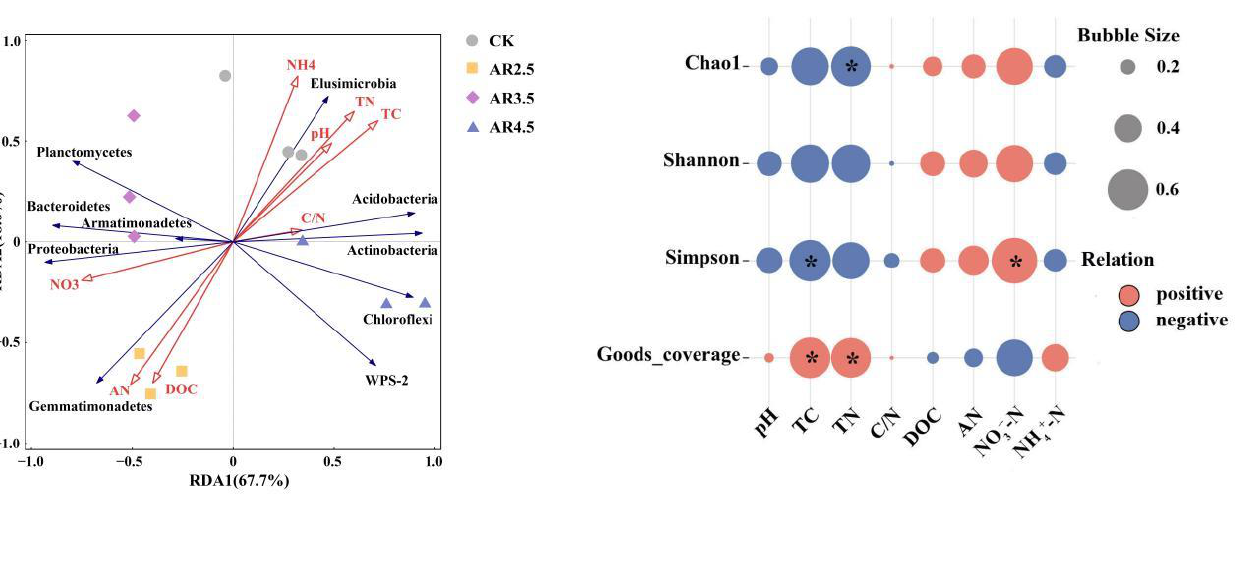
Figure 4. ( a ) Redundancy Analysis (RDA) of the effects on the soil bacterial community and soil environmental factors. ( b ) Bubble plot: Correlation analysis of soil chemical properties and bacterial community α -diversity indexes. The size of the circle indicates the size of the correlation coefficient. * indicate significant difference at p < 0.05. TC: total organic carbon; TN: total nitrogen; C/N: total carbon/total nitrogen ratio; DOC: dissolved organic carbon; AN: alkali-hydrolyzable nitrogen; NO3: nitrate nitrogen; NH4: ammonium nitrogen. CK: control without acid rain; AR2.5: Acid rain at pH 2.5; AR3.5: Acid rain at pH 3.5; AR4.5: Acid rain at pH 4.5.